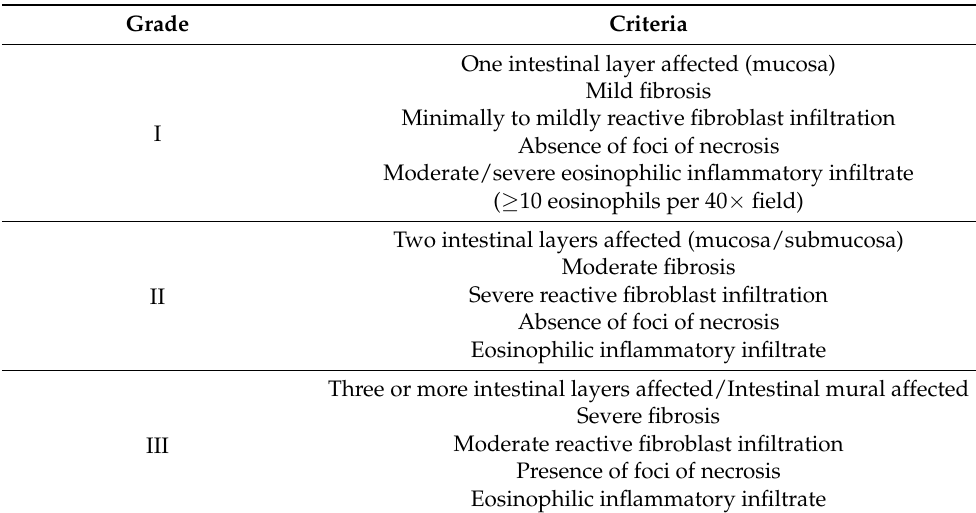
Table 3. Histological criteria for classifying each evolutionary grade of FGESF. Grade